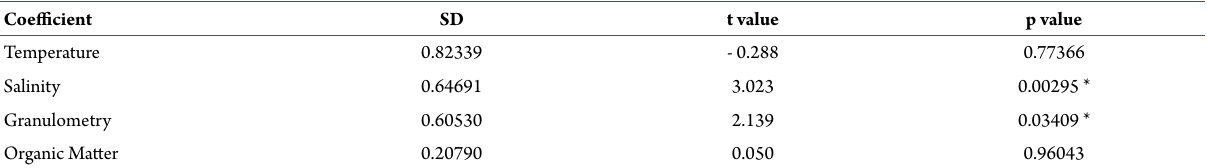
Table 2. Results of the Multiple Linear Regression test, highlighting the environmental variables with a significant influence (*) on the abundance of Exhippolysmata oplophoroides , from July/2012 to June/2014, in Cananéia region,